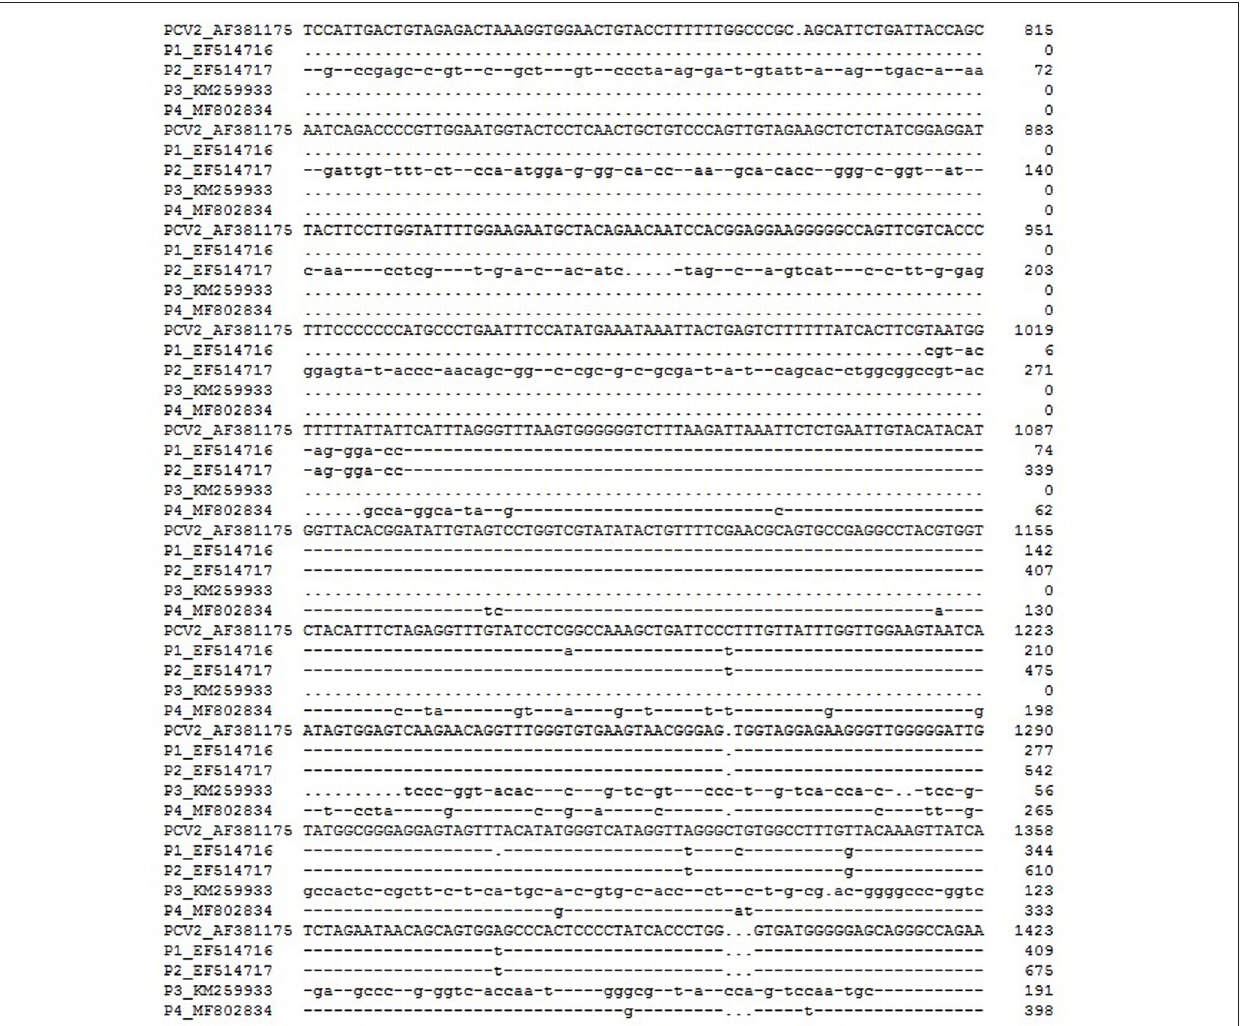
FIGURE 1 | Multiple alignment of nucleotide sequences of the PCV-like viruses and PCV2. Numbers at the 3’-terminal ends indicate the length of the nucleotide sequences in each species. The full-length genome sequences of PCV2 and PCV-like viruses are not shown. The omitted 3’-terminal nucleotide sequences are highly homologous nucleotide sequences. Deletions (. dots in the sequence), identical nucleotide sequence (– dashes in the sequence).